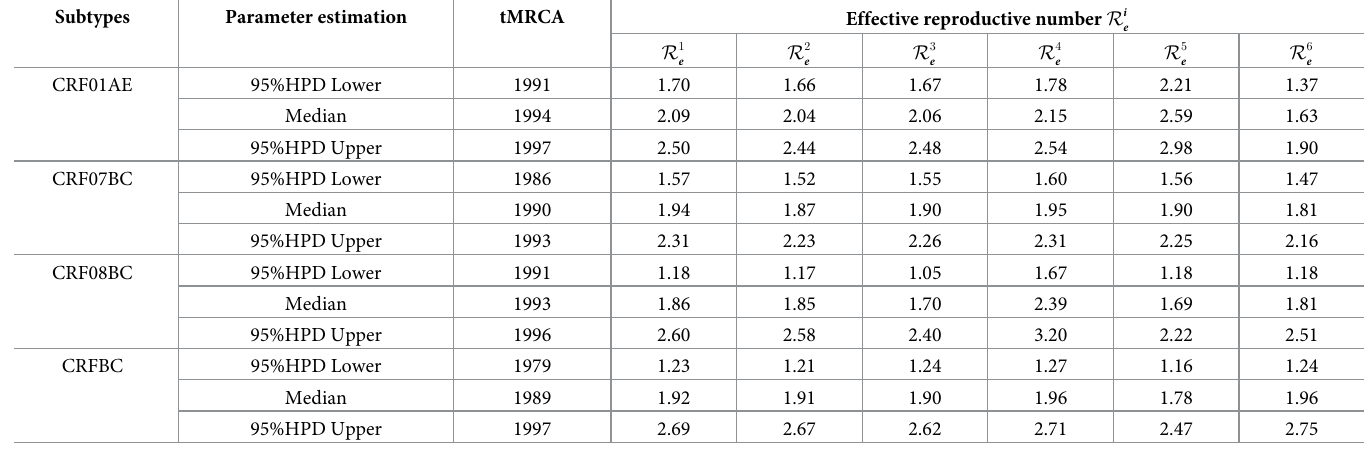
Table 2. Estimation of each subtype and its 95%HPD